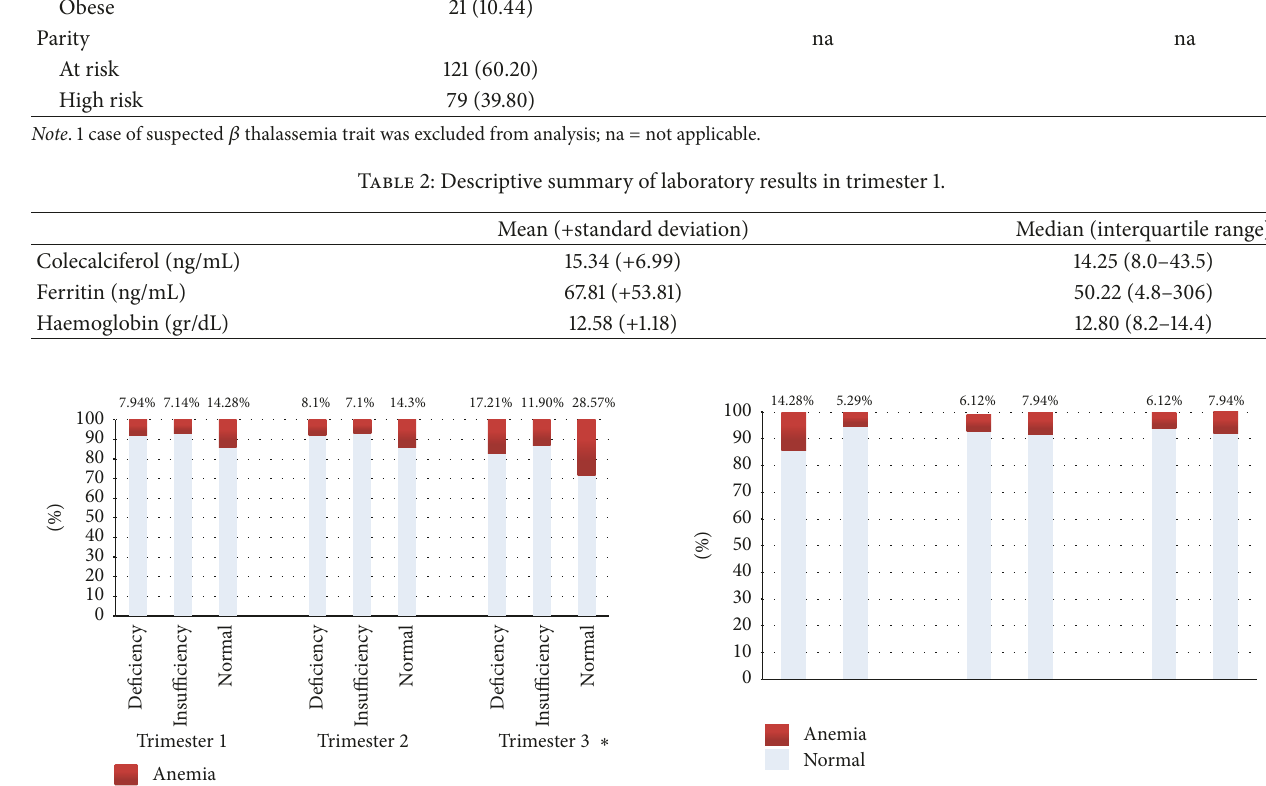
Figure 2: Proportion of subjects with anemia in trimesters 1, 2, and 3 by first trimester ferritin status. Correlation of first trimester ferritin level and first trimester anemia ( 𝑟 = 0.147 , 𝑝 = 0.038 ), no correlation found with second or third trimester